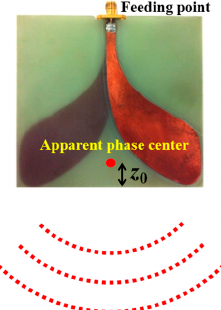
Figure 4. The apparent antenna phase center. The dotted curves denote wavefront radiated from the apparent phase center at three different range distances. apparent phase center at three different range distances.